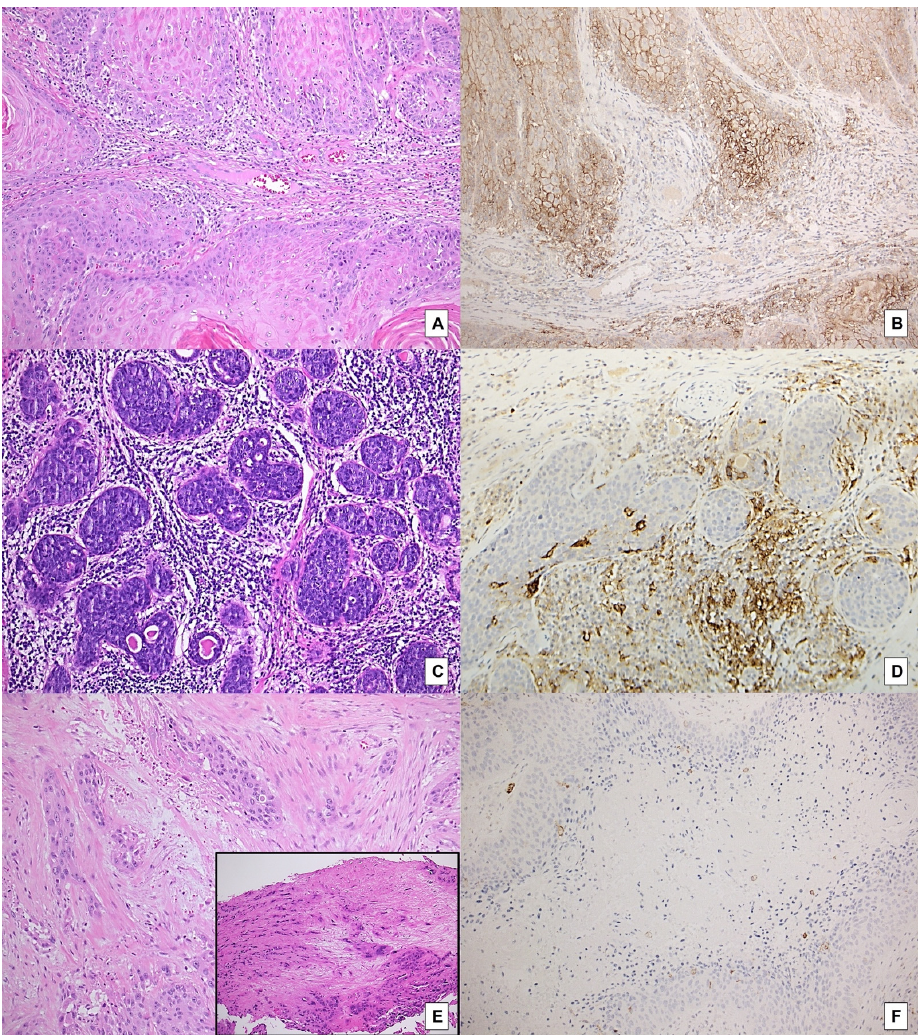
Figure 2. Association between TSR and other clinical–pathological variables on both biopsies and paired surgical specimens: ( A ) surgical specimen with a high TSR (stroma-poor case) (H&E, original magnification 100 × ); ( B ) same case, showing a high expression of PD-L1 (CPS > 1), mainly by neoplastic cells (immunostaining for PD-L1, original magnification 100 × ); ( C ) another TSR- high case associated with high density of stromal TILs (H&E, original magnification 100 × ); ( D ) same case, showing a high expression of PD-L1 (CPS > 1), mainly by mononucleated inflammatory peritumoral cell (immunostaining for PD-L1, original magnification 100 × ); ( E ) a stroma-rich case (TSR low) on both biopsy (inset) and associated surgical specimen (H&E, original magnification 100 × ); ( F ) A stroma rich case displaying a nearly absent PD-L1 expression (CPS < 1) (immunostaining for PD-L1, original magnification 100 ×